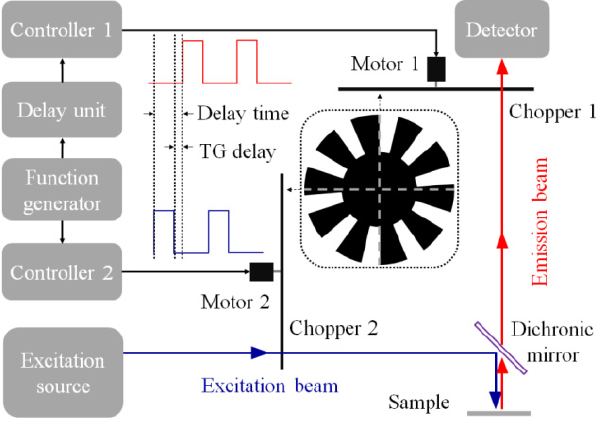
Fig. 3. TG implementation of